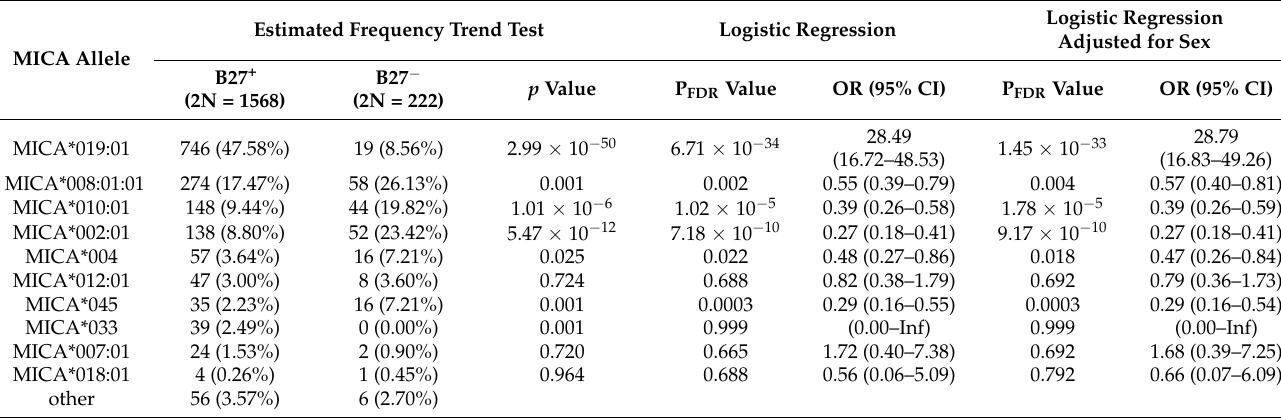
Table 3. Comparison of MICA allele frequencies between HLA-B27 + and HLA-B27 − AS